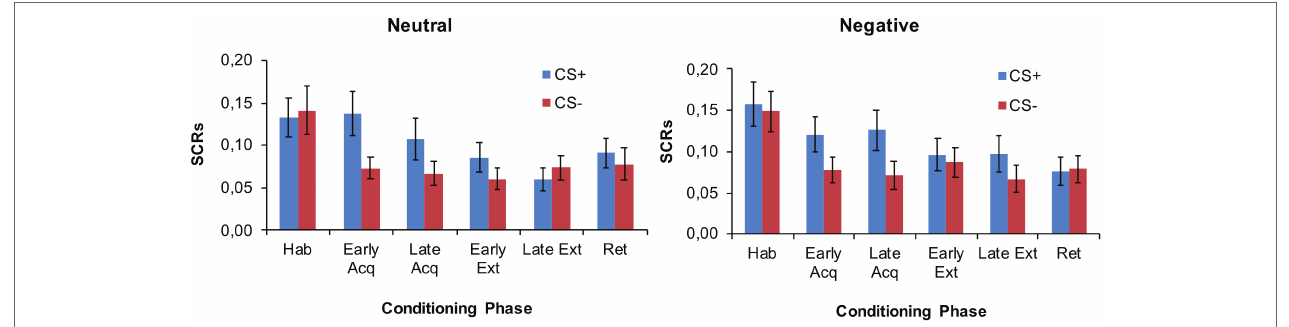
FIGURE 4 | Mean SCRs during each phase of conditioning in the neutral and negative